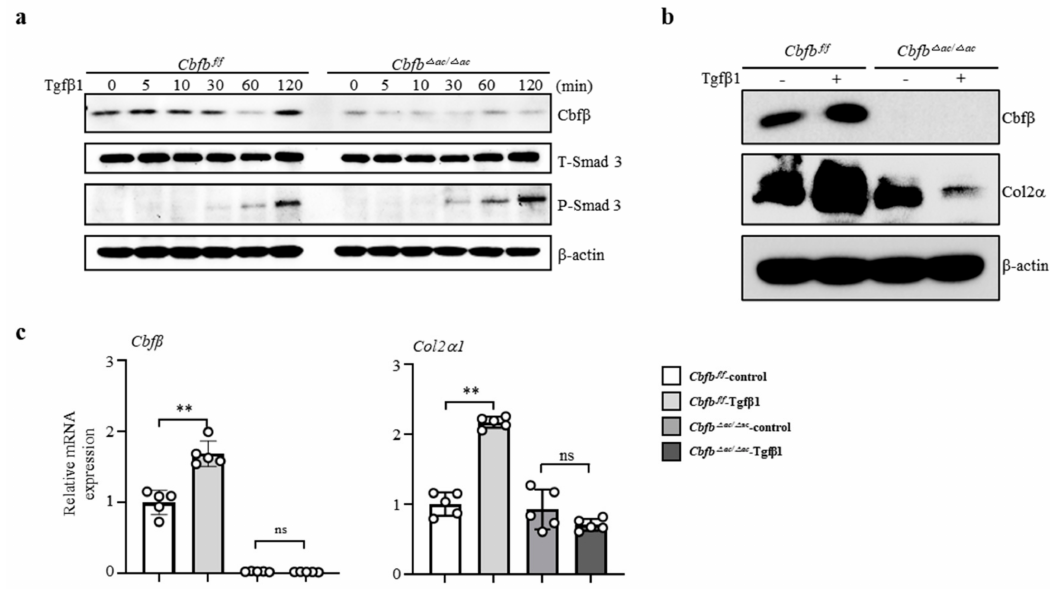
Figure 4. Impaired TGF- β 1-mediated Col2 α 1 transcription in Cbf β -deficient articular chondrocytes. ( a ) Cbf β , p-Smad3, and T-smad3 expression were evaluated with Western blotting in Cbf β (cid:52) ac/ (cid:52) ac articular chondrocytes. ( b ) Effects of TGF- β 1 treatment for 24 h on Cbf β and Col2 α 1 (Type II collagen) protein levels using Western blotting. ( c ) The expression of Cbf β and Col2 α 1 mRNA was